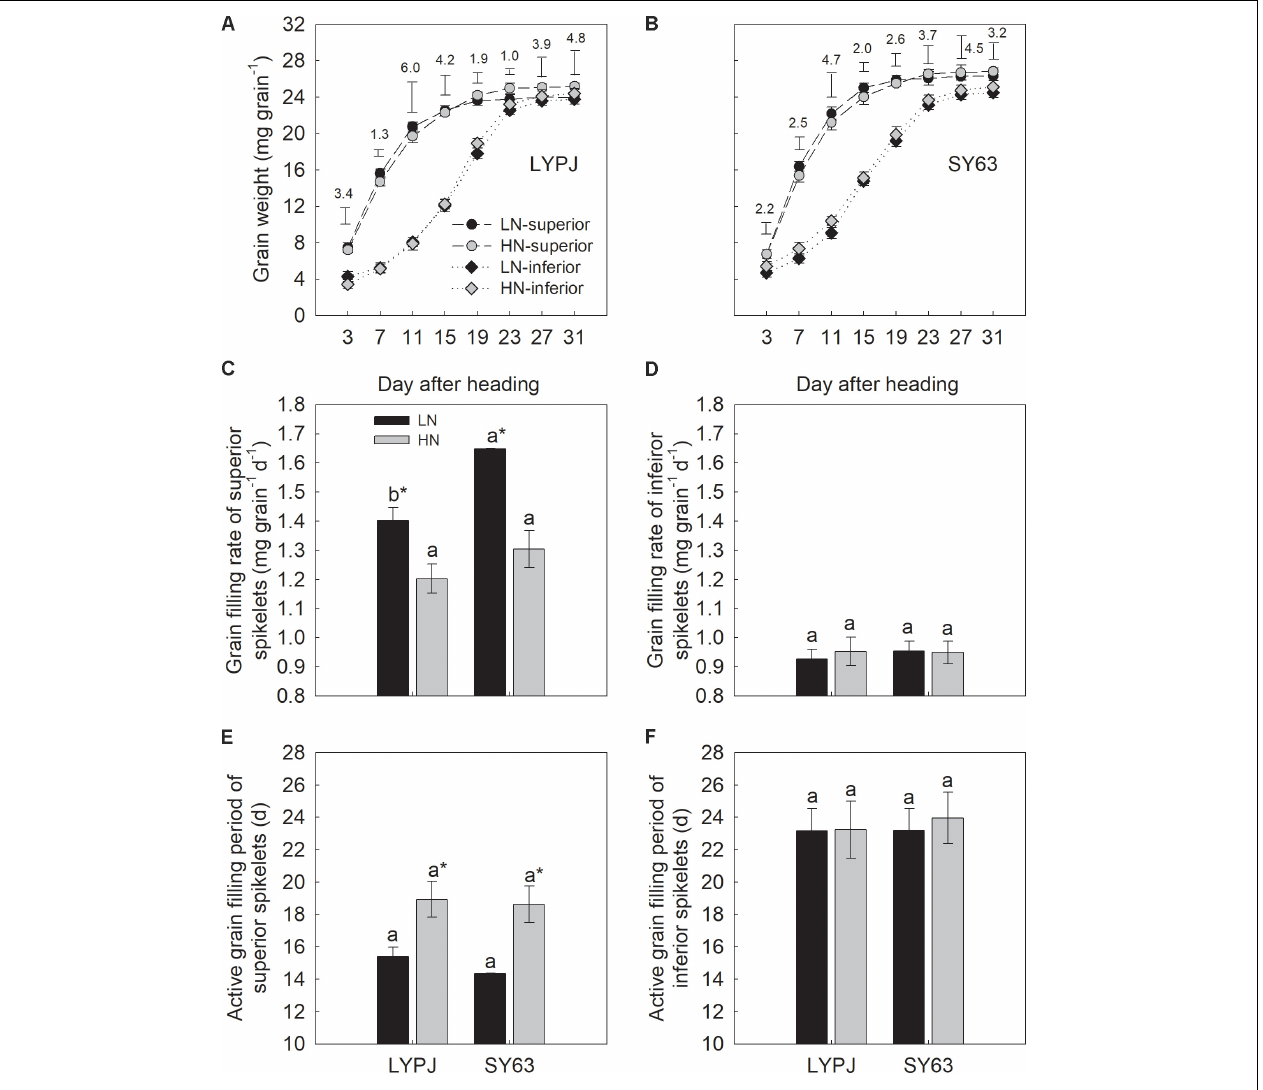
FIGURE 1 | Changes in grain weight (A,B) , grain filling rate (C,D) , and active grain filling period (E,F) of superior and inferior spikelets in LYPJ and SY63 cultivars during the grain filling period under LN and HN treatments. Data are shown as mean ± standard error ( n = 3). Vertical bar with number represents LSD 0 . 05 for difference significance of mean among 4 combinations at an identical time point. Different letters on top of histograms indicate significance at P < 0.05 between the two varieties under the same nitrogen condition. ∗ Indicates significance at P < 0.05 between the LN and HN treatments for the same